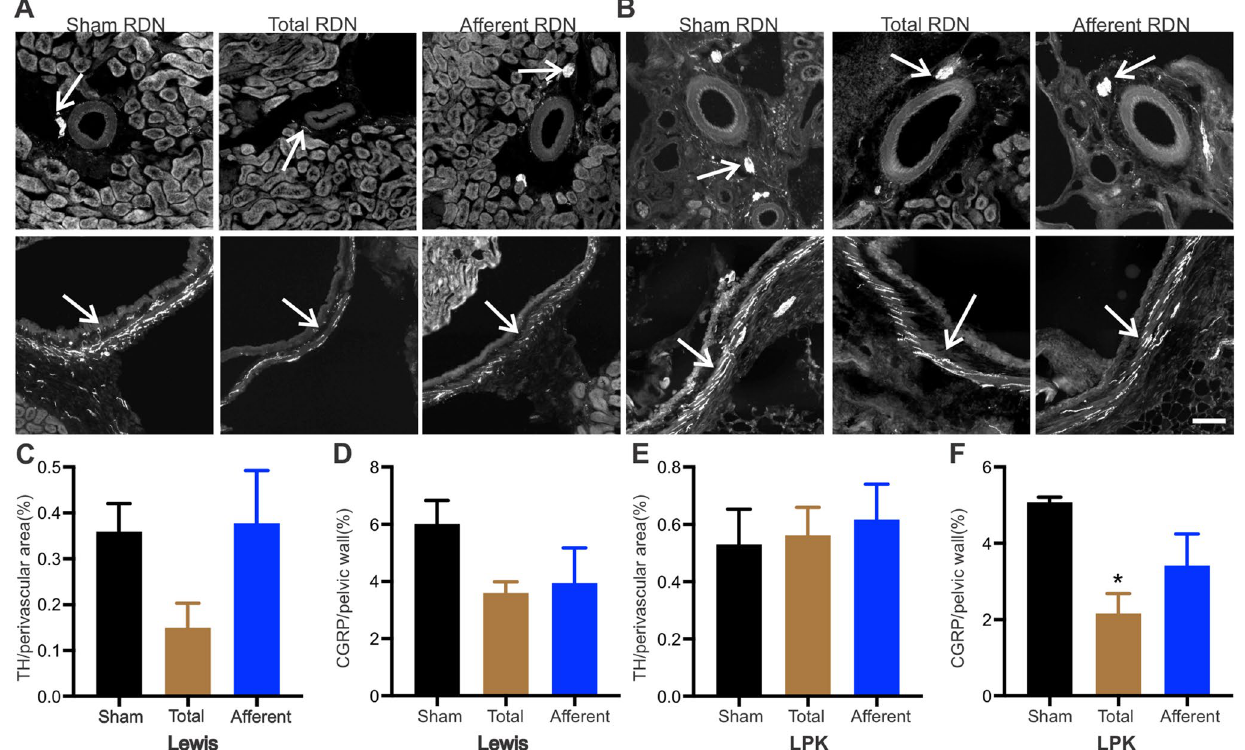
Figure 6. Renal reinnervation by immunohistochemical assessment of tyrosine hydroxylase (TH) and calcitonin gene-related peptide (CGRP) innervation density four-week post-denervation as markers for sympathetic and sensory nerves, respectively. Representative images of TH (top row) and CGRP (bottom row) staining at 4 weeks post sham, total and afferent RDN in the Lewis ( A ) and LPK ( B ). Arrows indicate positive staining and scale bar in lower panel = 100 µm for all images. Quantitative analysis is shown in panel ( C – F ). Data is expressed as mean ± SEM. *indicates P < 0.05 difference vs. sham RDN, analysed using one-way ANOVA and Bonferroni’s post hoc analysis. N = 4–5, per treatment group per